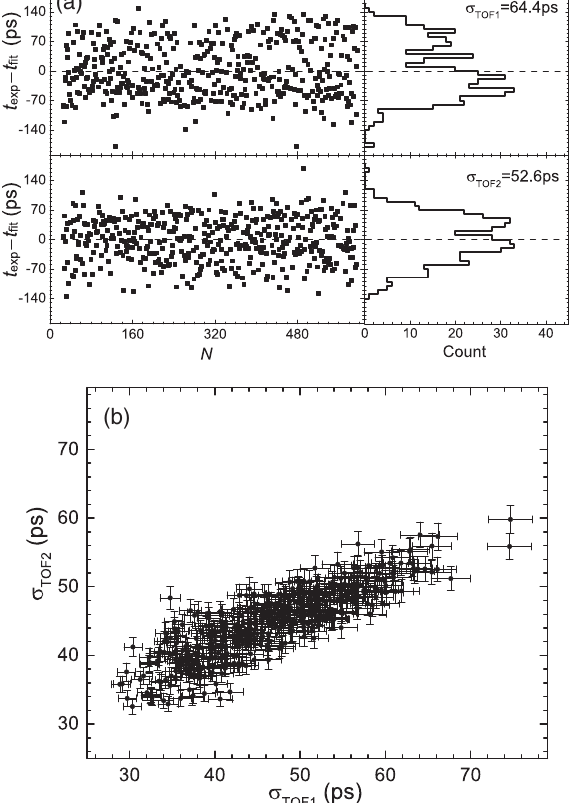
FIG. 6. (a) Residuals of the polynomial fitting as a function of the revolution number N (left) and their projection (right) for the single 45 V 23 þ ion as in Fig. 2. (b) Correlations between σ σ for all 45 V 23 þ ions identified in this experiment. TOF 1